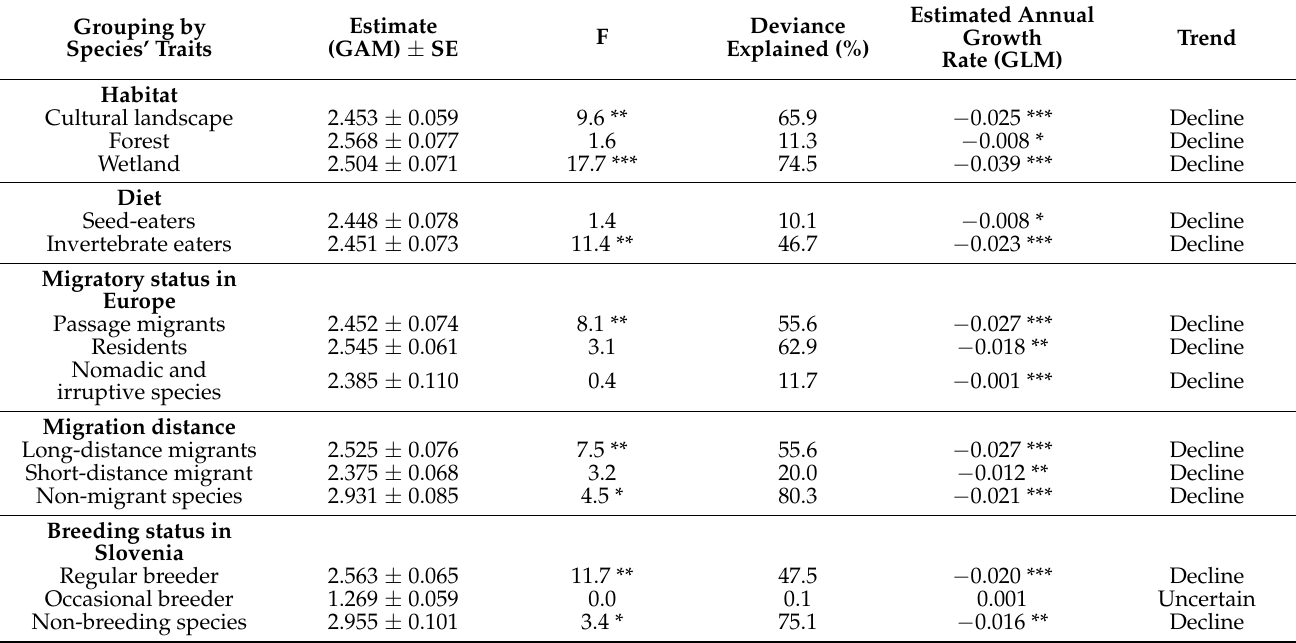
Table 3. Population trends in species trait guilds. Abbreviations: SE: standard error.